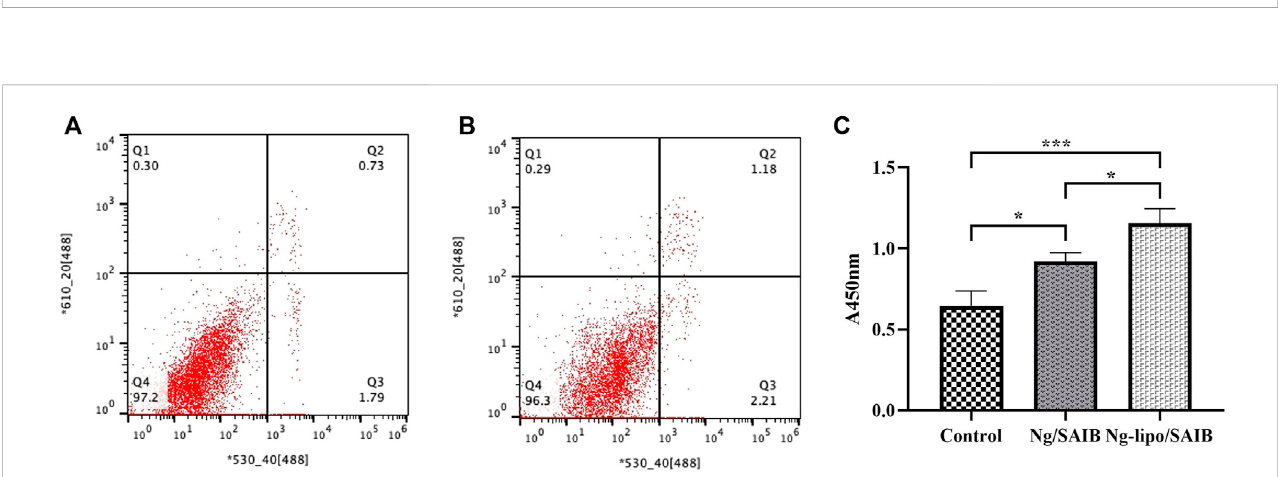
FIGURE 4 FlowcytometryofapoptoticosteoblastcellsassessedusingannexinV-FITC/PI fl uorescentintensity.Osteoblastcellsculturedwithbasalmedium (A) and withNg-lipo/SAIBdepotextractsolution (B) .Cellsharvestedafter24 h (C) CCK-8assaysofcellsculturedwithbasalmedium,andextractsofNg/SAIBandNg- lipo/SAIB depots ( n = 3, * p < .05).